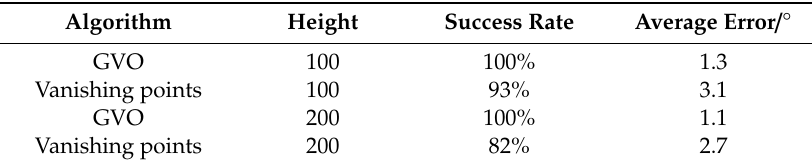
Table 5. Comparison between GVO and vanishing points